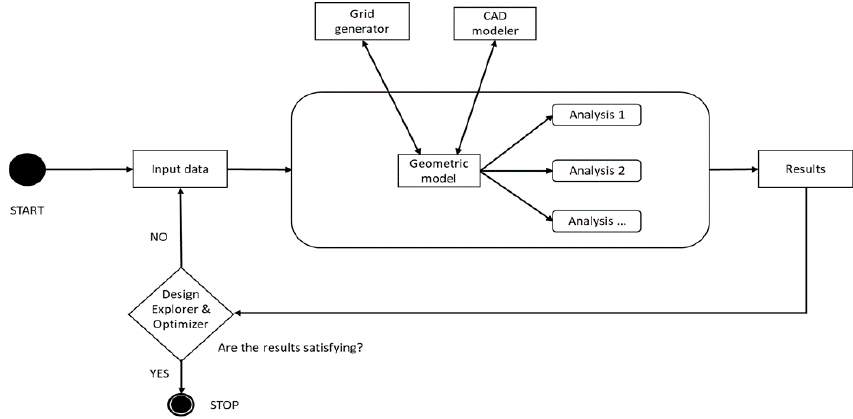
Figure 2. MDO framework with geometric model in the loop.